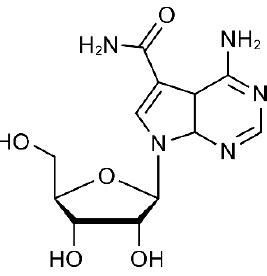
Figure 7. Sangivamycin : 4-amino-7-( β -D-ribofuranosyl)pyrrolo[2,3- d ]pyrimidine-5-carboxamide (C 12 H 15 N 5 O 5 ); Chemical Abstract Service #18417-89-5; molecular weight: 309.27. Remdesivir also is a nucleoside analog [8], but neither remdesivir nor GS-441524 (the parent nucleoside to remdesivir) affected VP40 perimembrane. Sangivamycin therefore is